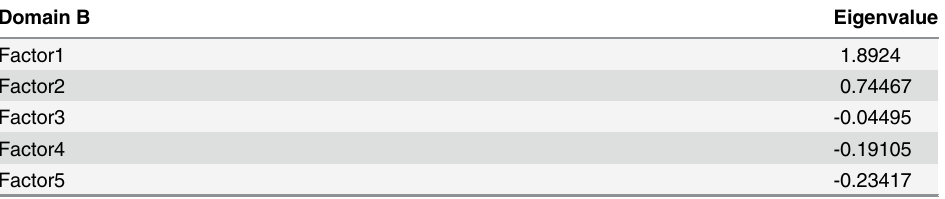
Table 4. Eigenvalues of the domain B in the Osteoporosis Prevention and Awareness Tool (OPAAT) using exploratory factor analysis (EFA).